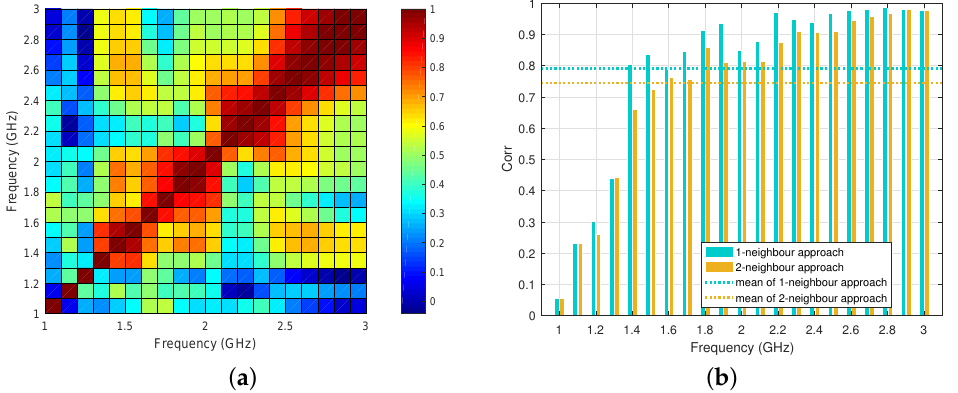
Figure 8. ( a ) Average cross-correlation map using Equation (9) for all transmitters and experimental data in a two-layer phantom with 90% corn syrup as immersion, and safflower oil surrounding the target; ( b ) Example of using the 1-neighbour and 2-neighbour approach to assess the correlations of the map in ( a ) through calculating moving averages of correlation